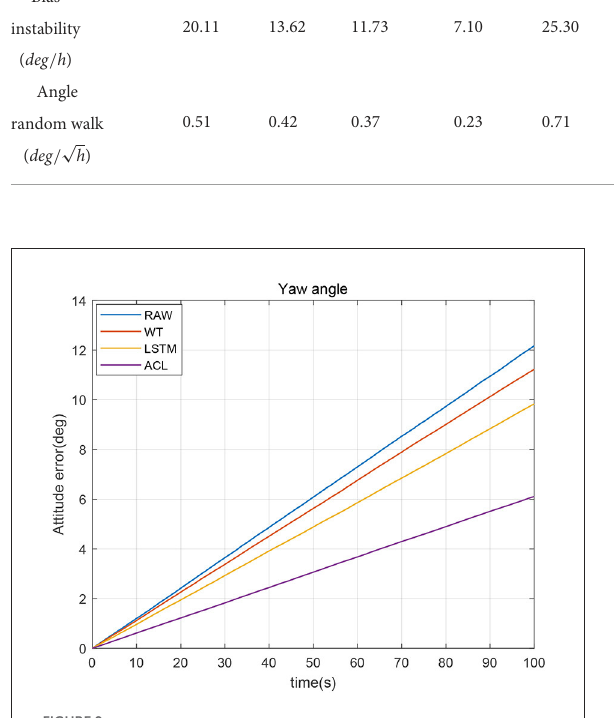
FIGURE9 The yaw angle error of the denoised and raw signals.